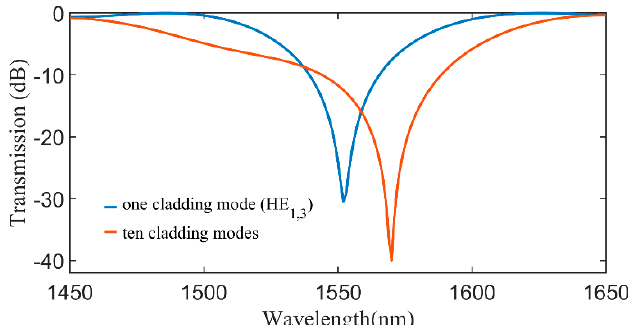
Figure 4. Transmission spectra calculated considering only two modes or the ten first azimuthally symmetrical cladding modes, a δ n cl = 2 × 10 − 3 , a period of 1117 µ m and length of 7 periods.